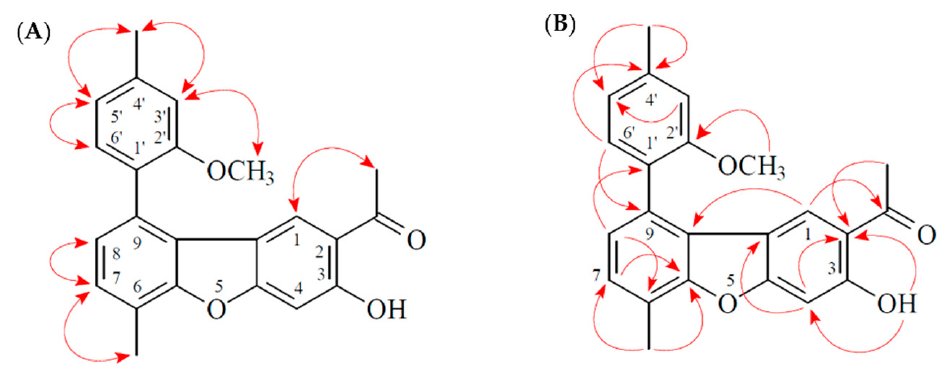
Figure 3. Key ROESY ( A ) and HMBC ( B ) correlations of 2 . Compound 3 was isolated as light brown amorphous powder. Its molecular formula, C 14 H 16 O 4 , was determined on the basis of the positive HRESIMS at m/z 249.1123 [M + H] + (calcd 249.1121) and was supported by the 1 H and 13 C NMR data. The IR absorption bands of 3 revealed the presence of carbonyl (1686 cm − 1 ) function. Analyses of the 1 H and 13